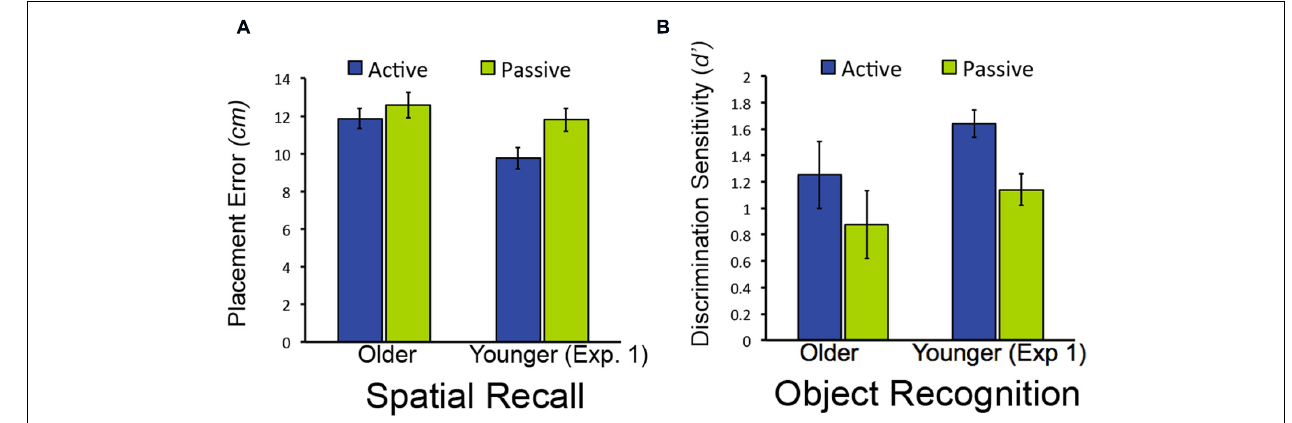
FIGURE 4 | Object-location recall and object recognition in Experiment 2. (A) Mean placement error for object-location recall in Experiment 2. (B) Mean performance (discrimination sensitivity) for object recognition in Experiment 1. Data from younger subjects from Experiment 1 are shown to facilitate